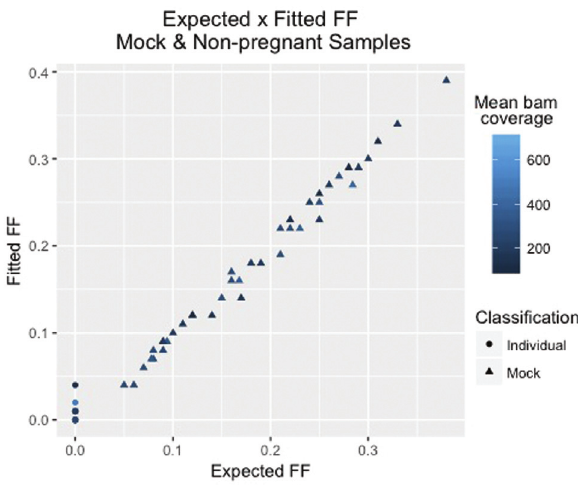
Figure 2 - Evaluation of the modeled fetal fraction (FF) and the mean cov- erage effect. Individual: Non-pregnant sample. Shape and color incorpo- ratebothindividualclassificationandmeancoveragevalue,respectively.